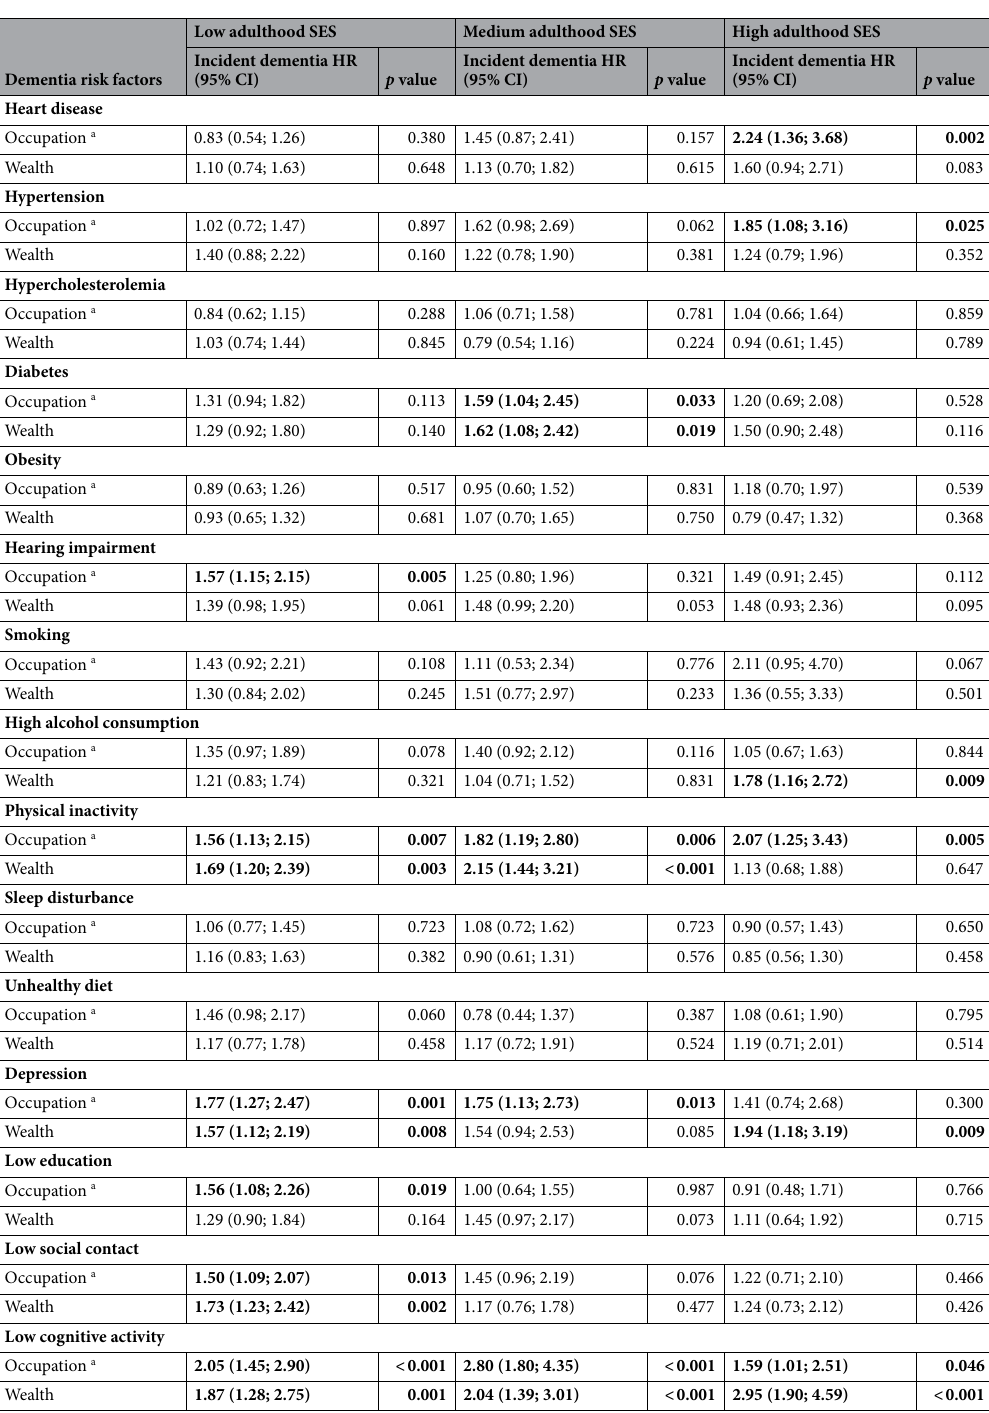
Table 4. The association of dementia risk factors with incident dementia stratified by indicators of adulthood socioeconomic status (occupation low/medium/high; wealth low/medium/high). Low occupation n = 3508 (181 dementia cases), medium occupation n = 2251 (111 dementia cases), and high occupation n = 3028 (92 dementia cases). Low wealth n = 2930 (167 dementia cases), medium wealth n = 3047 (129 dementia cases), and high wealth n = 2964 (100 dementia cases). SES socioeconomic status; HR hazard ratio; CI confidence interval. Analyses are adjusted for age, sex/gender, and clustering at the household level. a Data missing in n = 151. Significant values are in